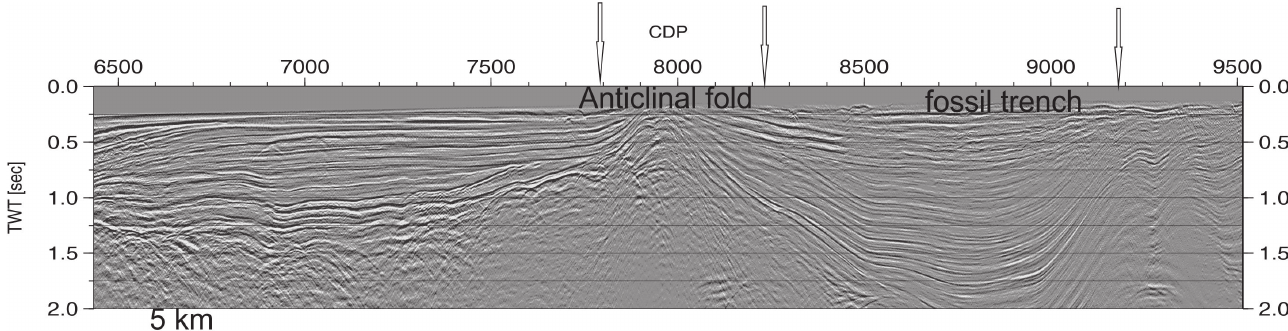
Figure 2. Time migrated image of seismic reflection line 89-06. Location of this line is shown in Figure 1. White arrows indicate projected locations of three exploration wells shown in Figure